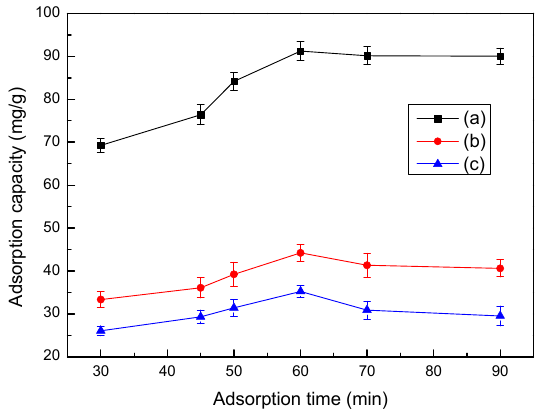
Figure 8. Effect of time on adsorption capacity LMT (a), MT (b), and LC (c). Adsorbent: 0.1000 g; initial Co(II) concentration: 0.0040 mol/L; pH: 5.6; and temperature: 75 °C.